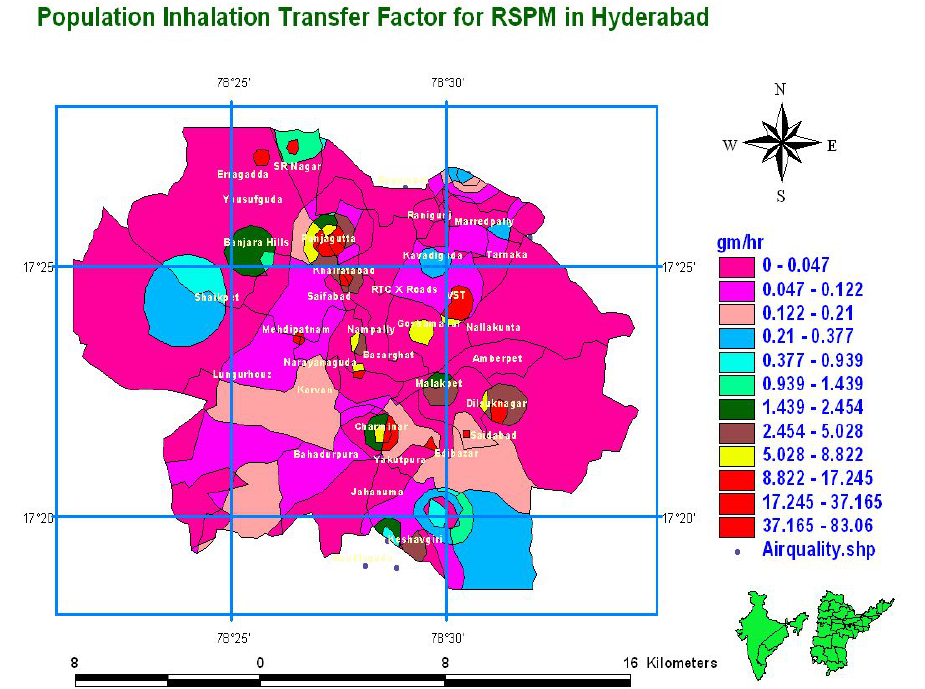
Figure 13: Population inhalation transfer factor for RSPM in